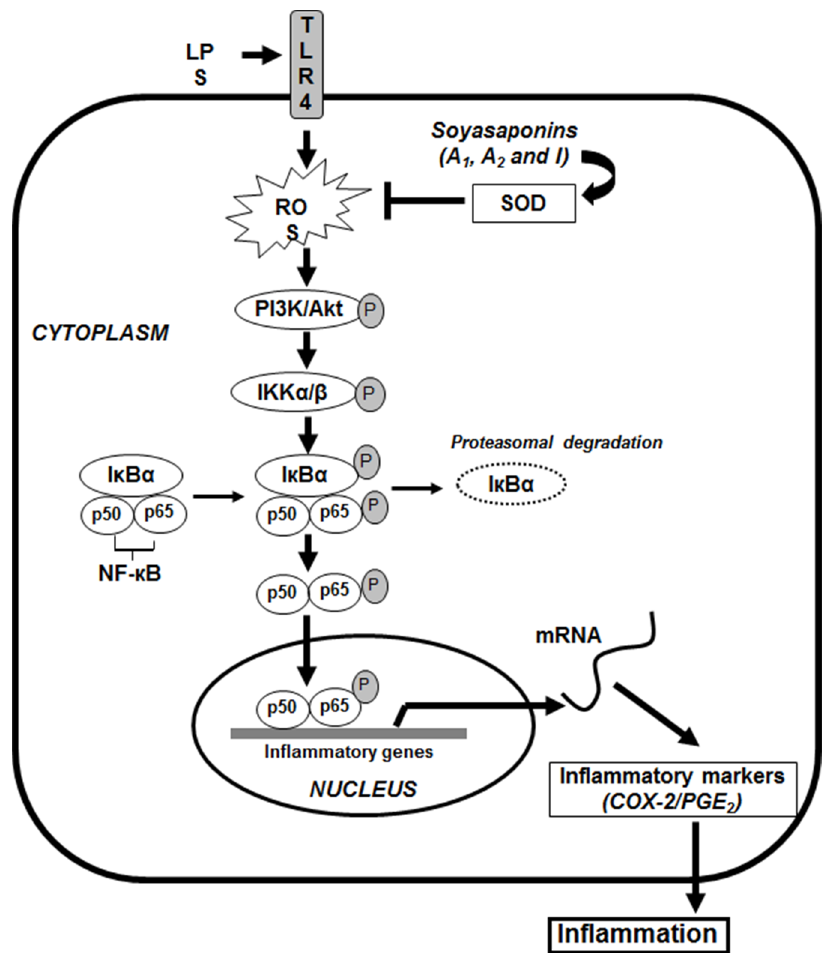
Figure 9. Schematic diagram of the targets of soyasaponins.